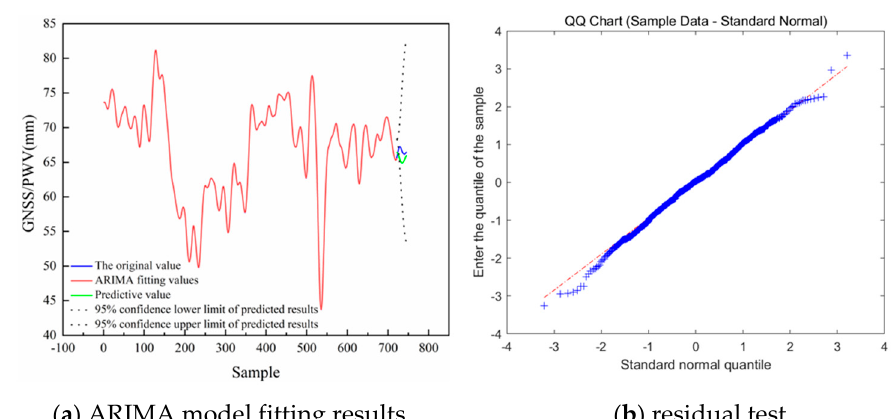
Figure 9. Reconstructed components: ( a ) Comparison of the trend terms with the original PWV data and a comparison of the high-frequency and low-frequency components; ( b ) high-frequency and low-frequency components reconstructed.